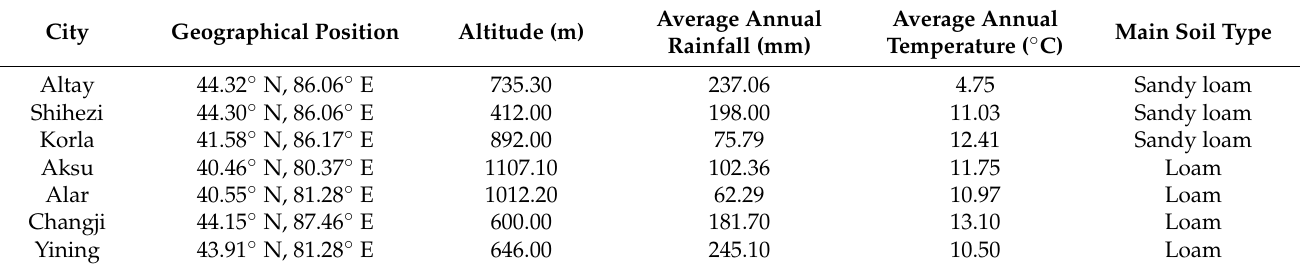
Table 7. Geographical position and main characteristics of each site for cotton in China.